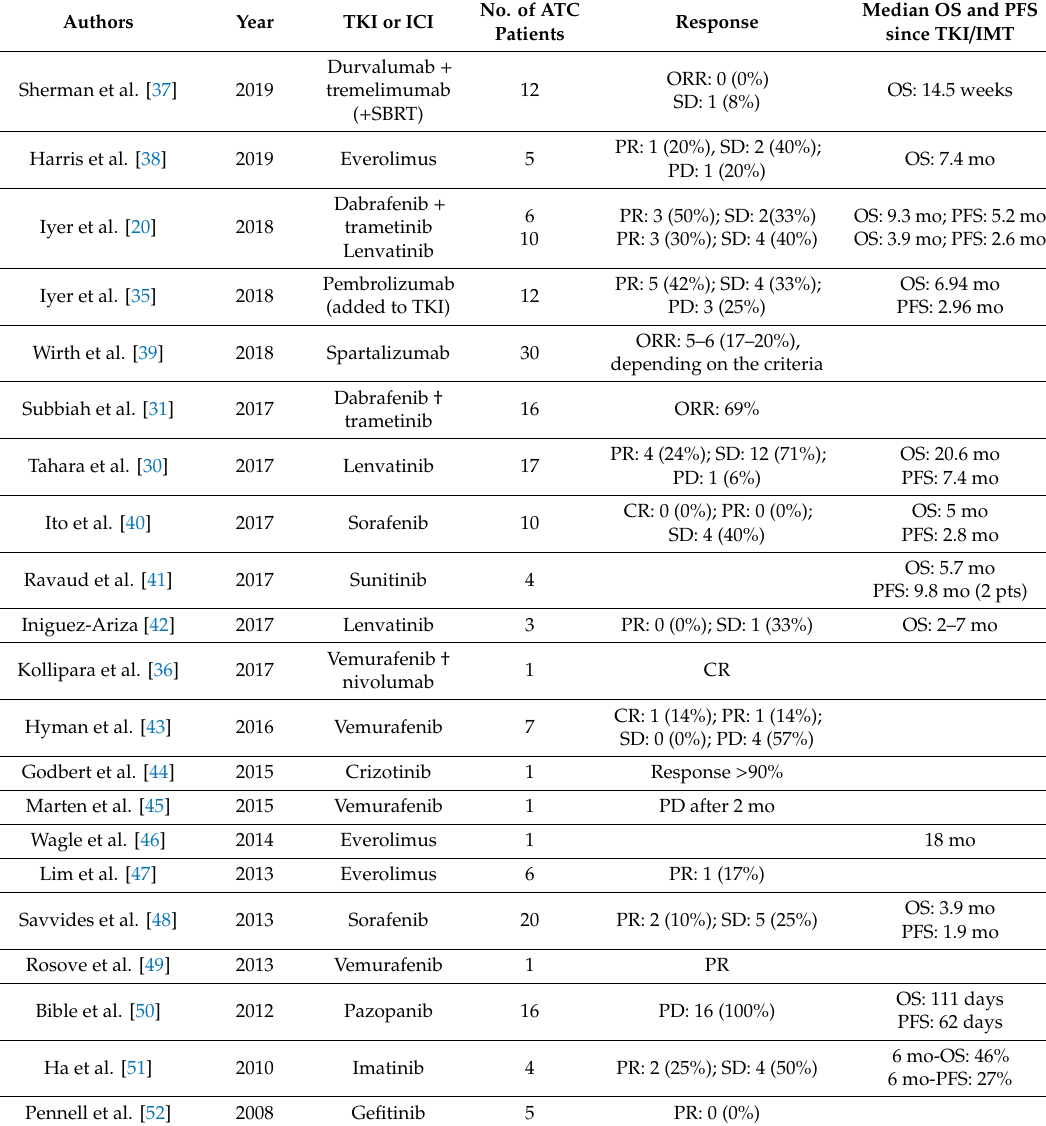
Table 4. Reported results of tyrosine kinase and immune checkpoint inhibitors in